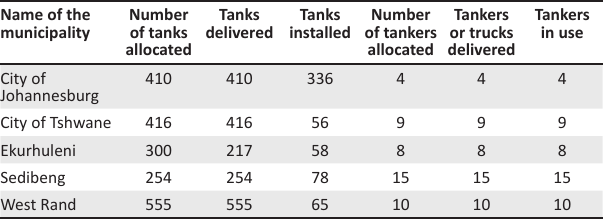
TABLE 4: Western Cape intervention. Name of the municipality